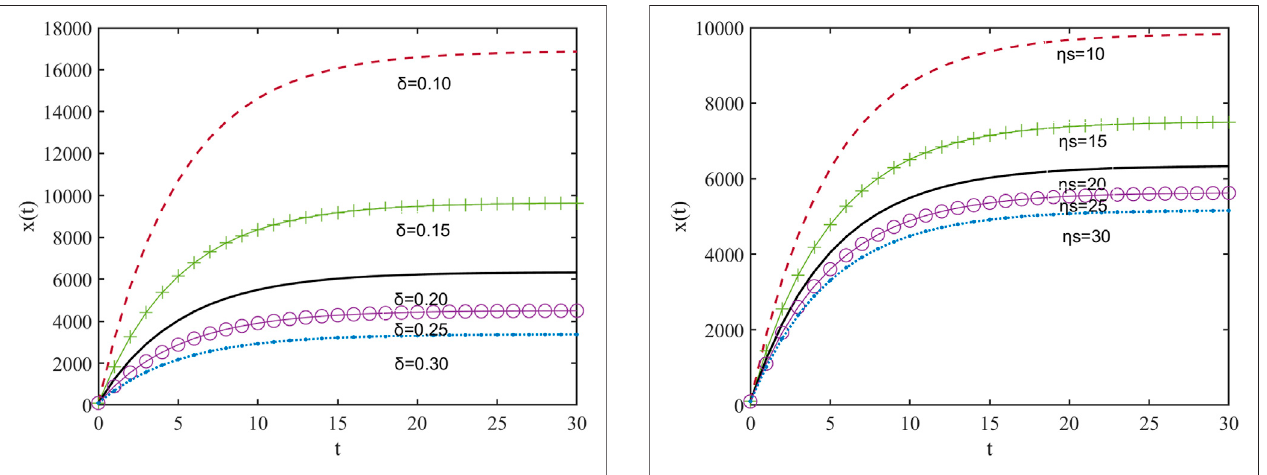
FIGURE 7 | The impact of δ on x ( t ) . FIGURE 8 | The impact of η S on x ( t )